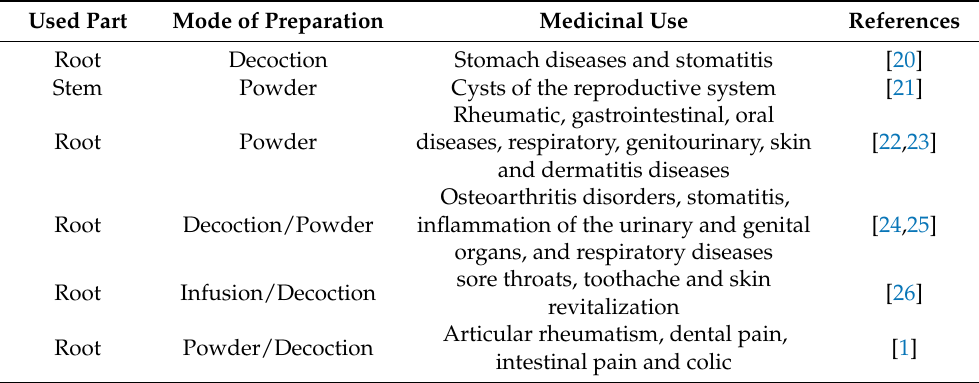
Table 1. Therapeutic actions of A. pyrethrum